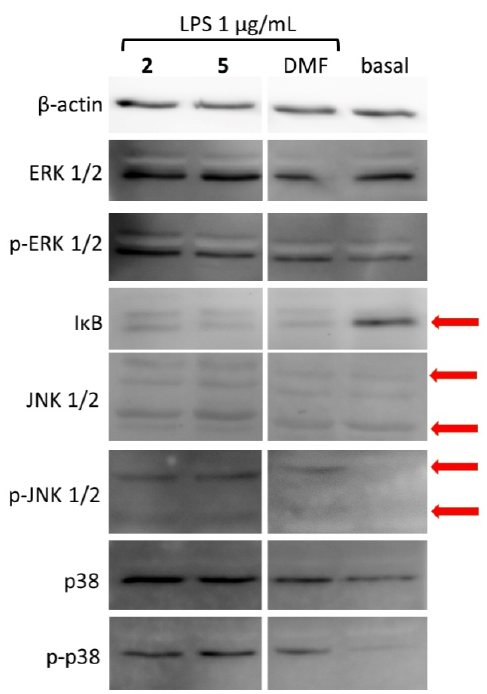
Figure 9. The effect of complexes 2 and 5 on the activation of MAPKs. THP-1 cells were differentiated to macrophages by PMA. The cells were pre-treated by complexes 2 and 5 (200 nM) for 1 h, then LPS (1 μ g/mL) was added to trigger the inflammatory response. Cells were collected 30 min after LPS stimulation. The amount of proteins was detected by Western blot and immunodetection. Present immunoblots show the results of pooled four independent reactions. Arrows indicate the correct position of particular proteins.